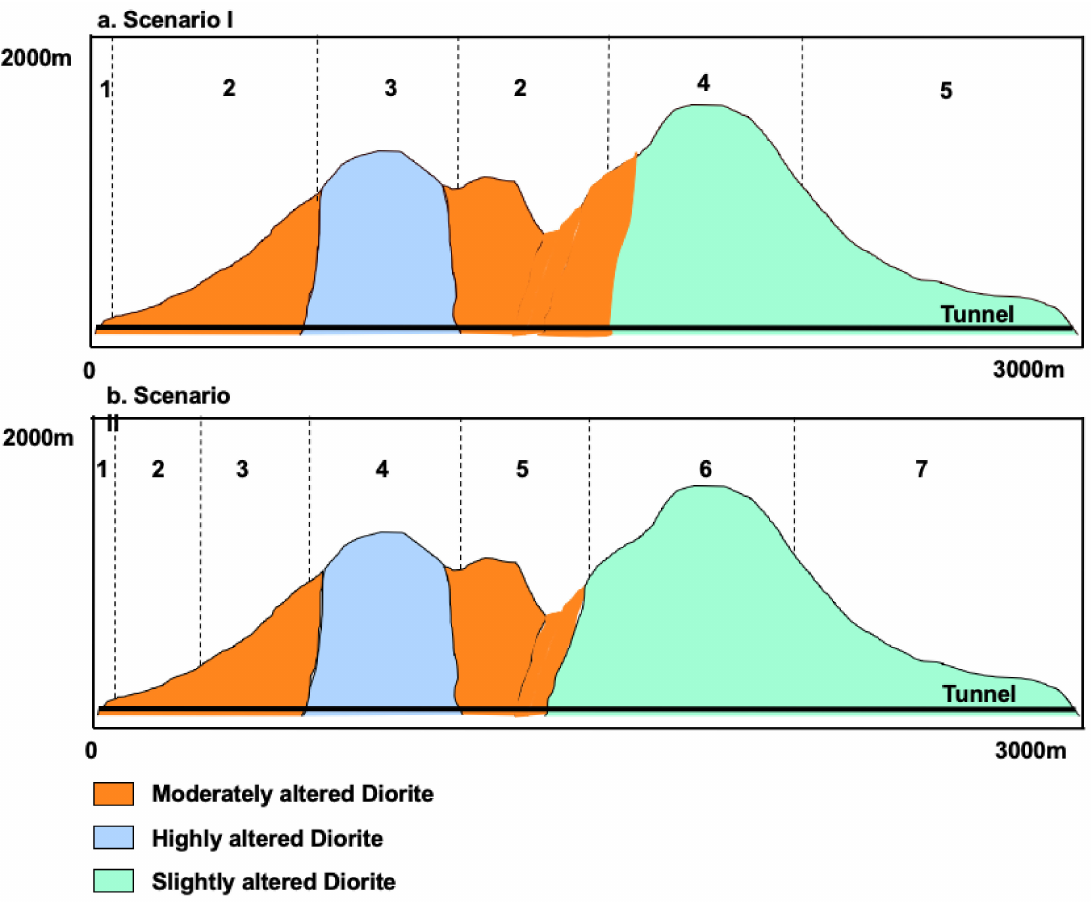
Figure 19. Geotechnical Units of ( a ) Scenario I—5 Geotechnical Units and ( b ) Scenario II—7 Geotechnical